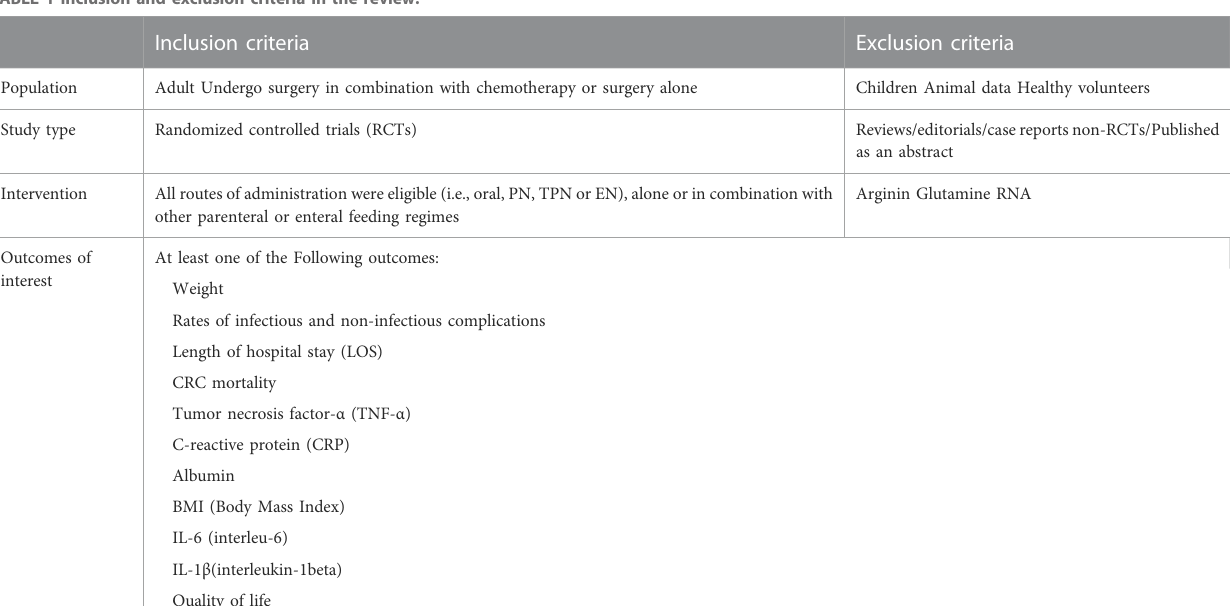
TABLE 1 Inclusion and exclusion criteria in the